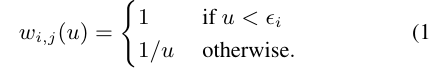
Selection of ground points The subset U corresponding to the selected ground points is obtained through a decimation heuristic based on a bucketing technique. Only points that are inliers to the attained quadric are taken into account. Hence, the space of the scene is divided in regular cells with predetermined